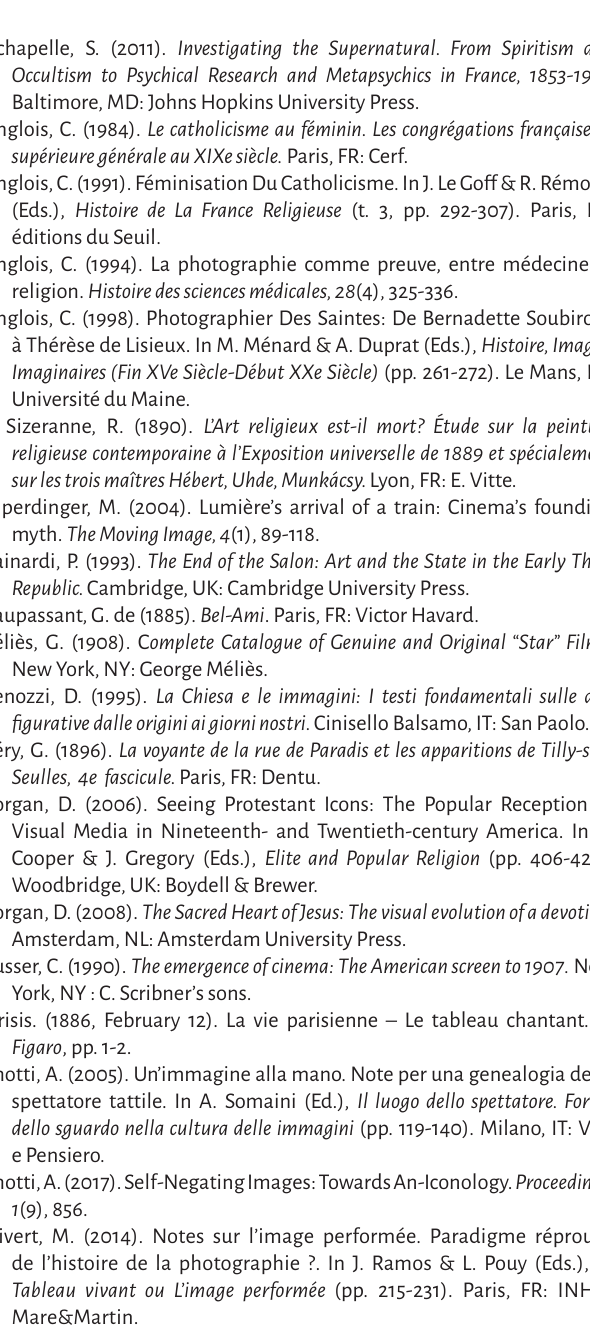
Tableau vivant ou L’image performée (pp. 215-231). Paris, FR: INHA-